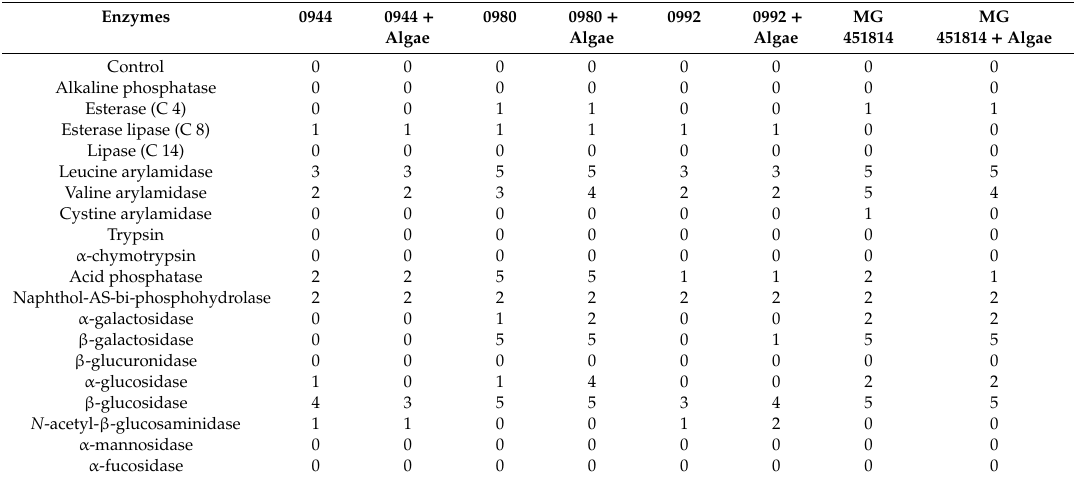
Table 5. Enzymatic profiles obtained by API ® ZYM for Lactobacillus strains cultured with and without the algae Chlorella vulgaris. Enzymes